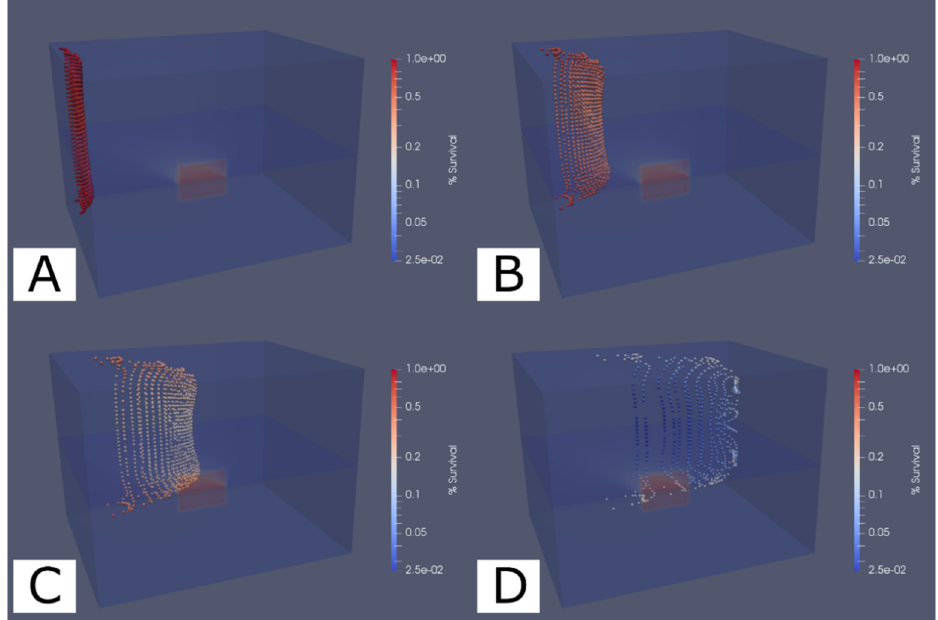
Figure 1. Simulation results of aerosol dosimetry showing the relative survival fraction of virus in aerosols as they traverse across the exposure chamber. Aerosols in the simulation were uniformly distributed across the left side of the exposure volume and released to move through the volume. The aerosol color changing from red to blue indicates an increase in the total radiation flux received by that aerosol over time. Four frames ( A – D ) show aerosol position at time instance of 2, 6, 10, and 20 s from entering the chamber. These frames illustrate the flow pattern as well as the virus inactivation for each aerosol. Panel A shows the aerosol particles evenly distributed as they begin into the exposure volume, and panels B and C show the particles progressing across the exposure volume. Panel D shows many of the particles have reached the two chamber outlet ports on the right side, while slower travelling particles are still being exposed. A video of the simulation result is available in the Supplementary Materials.